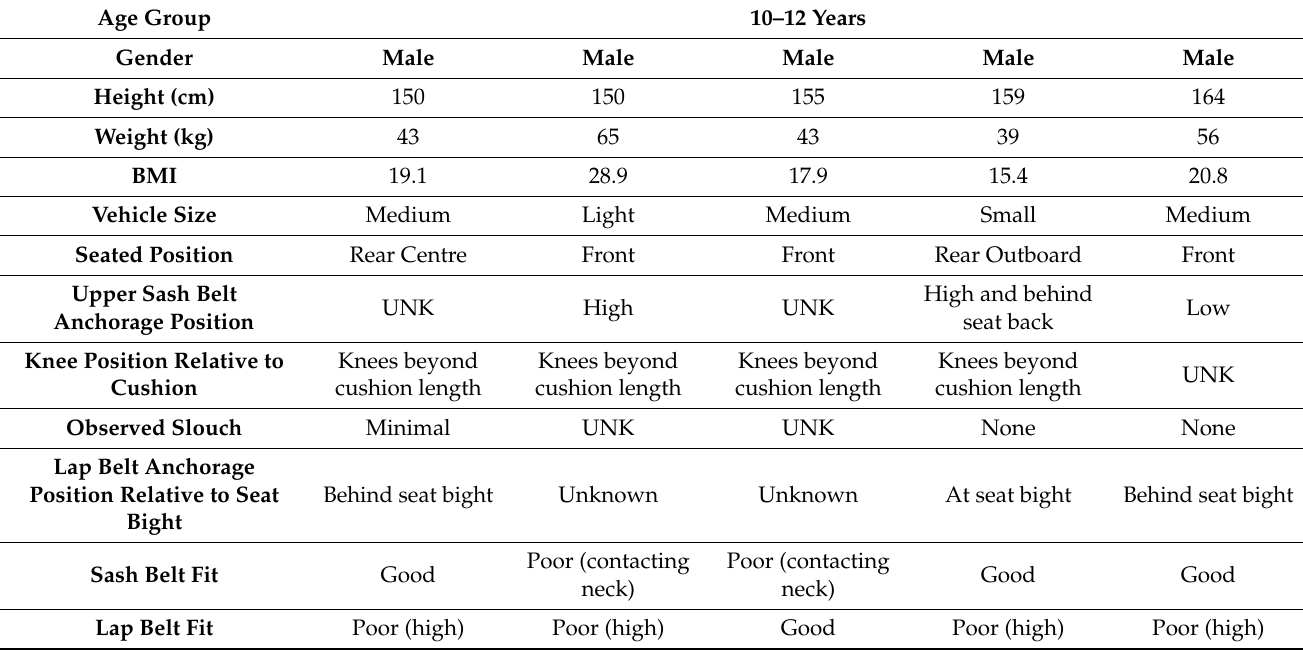
Table 5. Demographic and vehicle factors for cases taller and heavier than cut-offs, who did not achieve a good seat belt